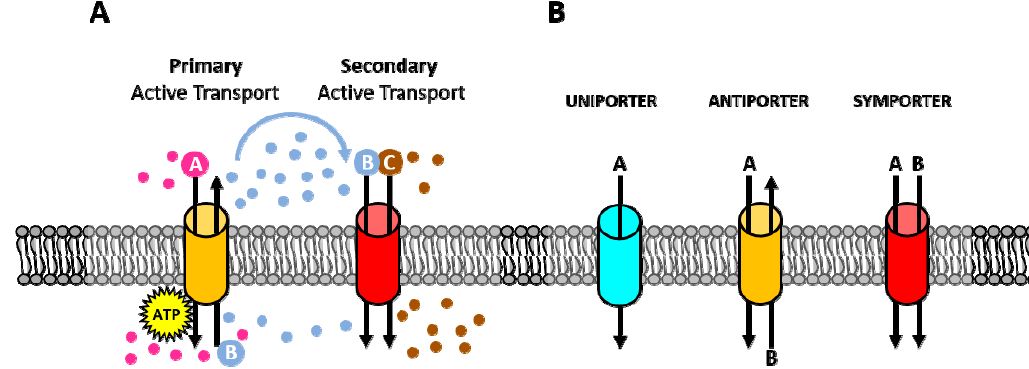
Figure 1. Different types of ion transport. (A) Active and secondary transport: Primary active transporter uses ATP to move ions across the membrane [A and B], against their electrochemical gradients to create an electrochemical gradient. Secondary active transporter uses the electrochemical gradient generated by primary active transporters to move one molecule down its gradient [B] while transporting another molecule against its electrochemical gradient [C]. (B) Uniporter, antiporter, and symporter: Uniporter carries one molecule or ion in one direction. Antiporter carries two different molecules or ions in opposite directions. Symporter also carries two different molecules or ions in the same direction.